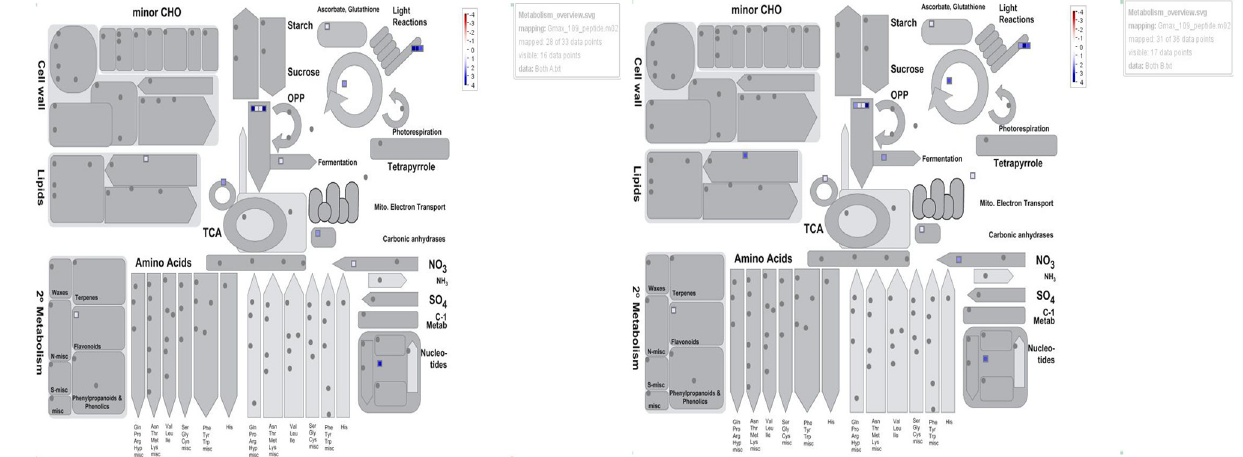
Fig 4. Phytozyme confirmations of protein identities using MapMan.